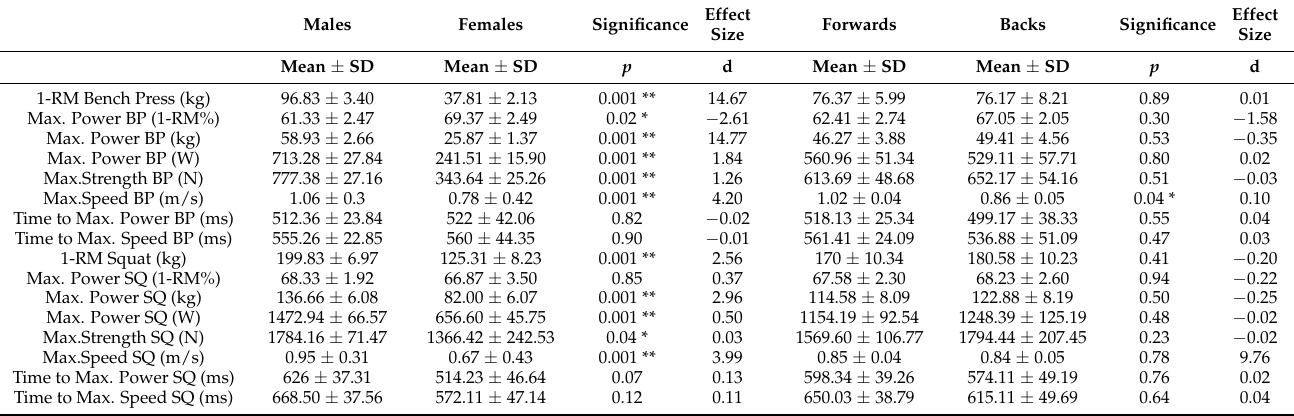
Table 1. Differences between genders and